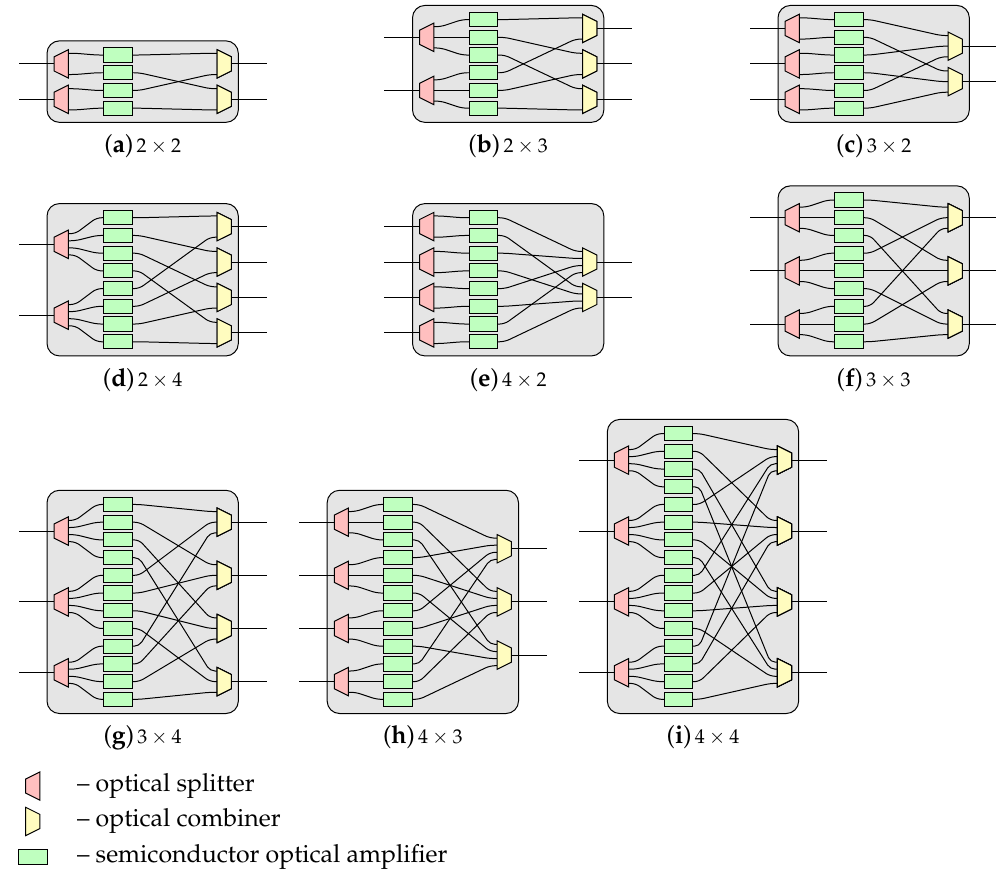
Figure 4. Optical switching elements (OSE) of different sizes.